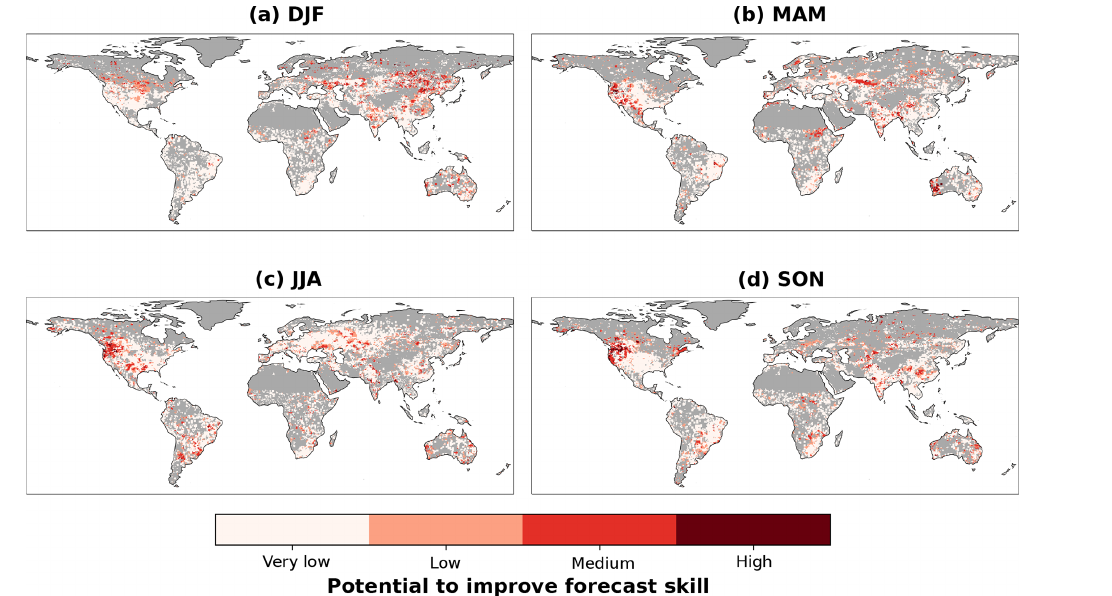
Figure 7. Potential for improvement in temperature forecast skill according to magnitude of forecast error from Fig. 2 and mean correlation value from Fig. 4.